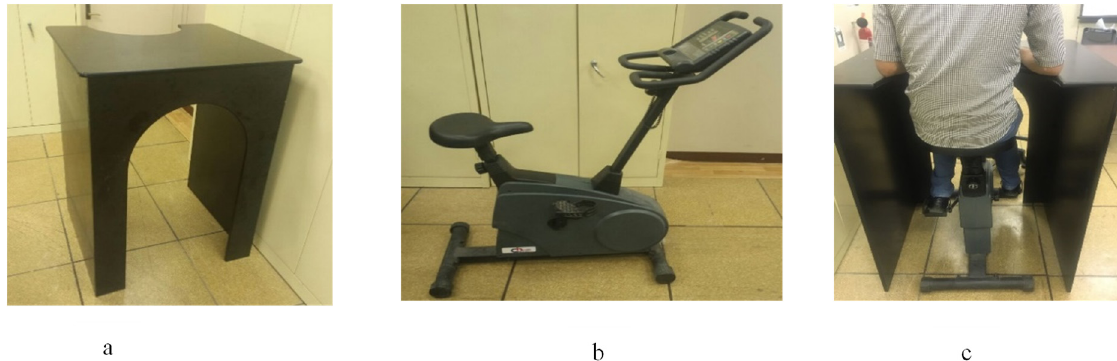
Figure 2. Experimental setup; ( a ) an office workstation; ( b ) stationary bike; ( c ) adjusting work station.